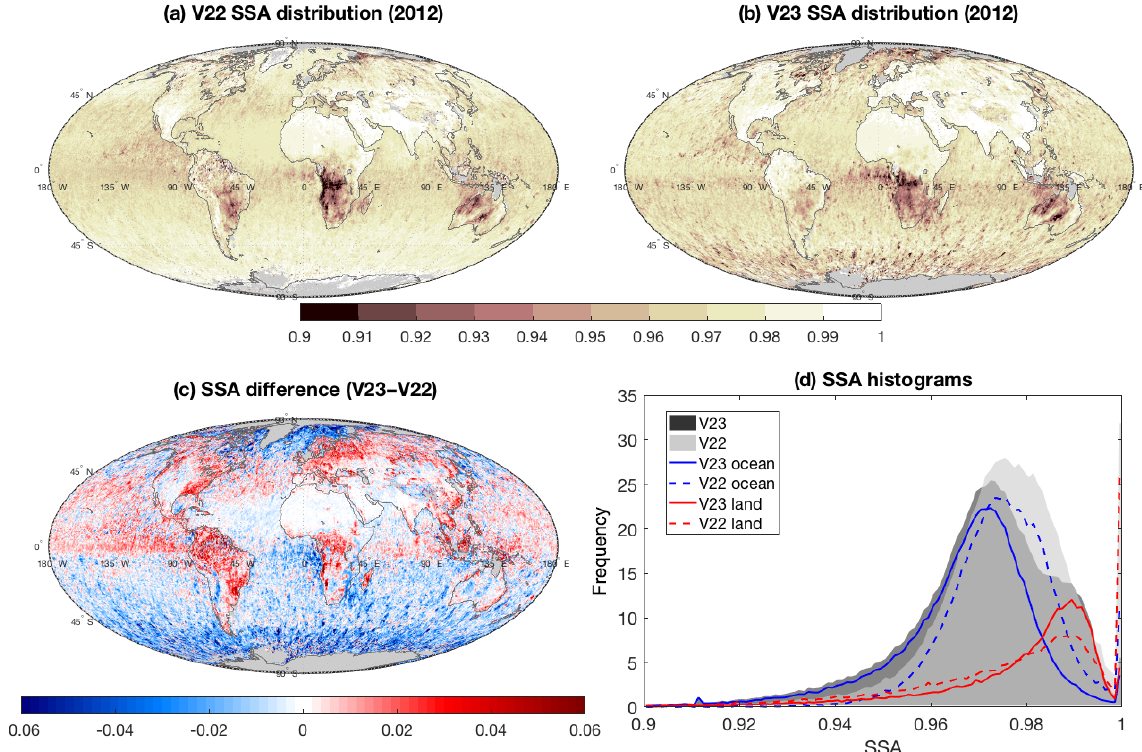
Figure 10. As in Fig. 7 except for the MISR-retrieved SSA. AOD weighting is applied in SSA averaging at each grid box.